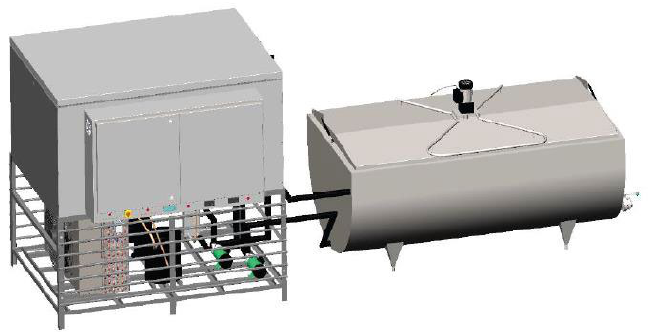
Figure 3. 1000 L bulk milk cooler with ice storage (source: Inficold).